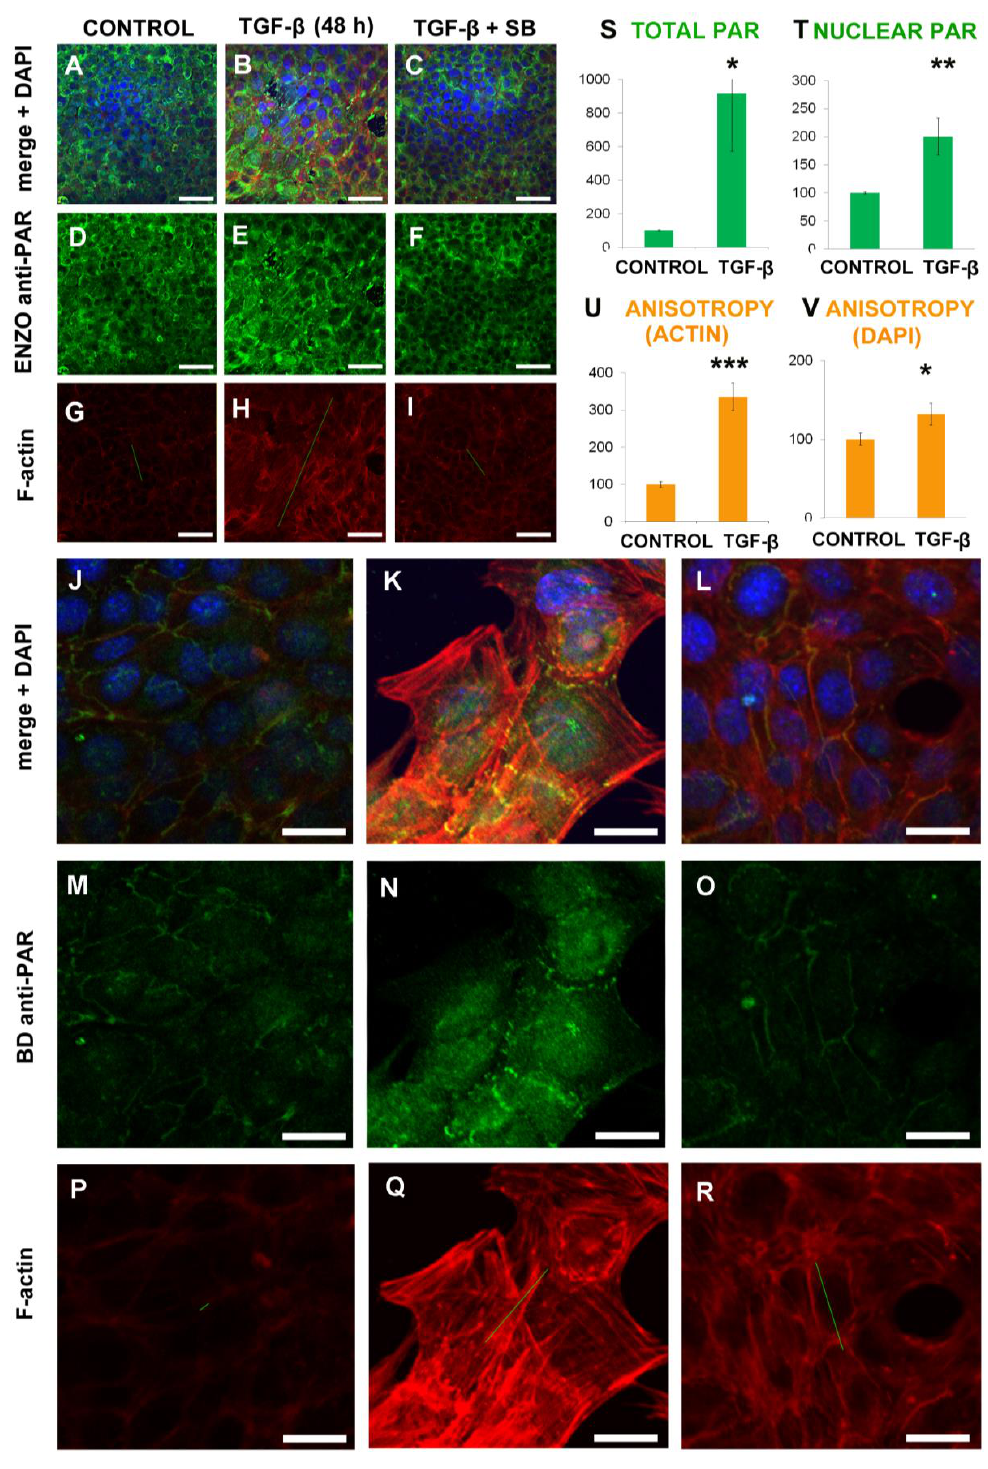
Figure 1. TGF- β induced NMuMG cells anisotropy increases together with changes in nuclear, cytoplasmic, and belt PAR. Control NMuMG cells were subjected just to 4 h of serum depletion. Other cells were also treated with TGF- β (5 ng/mL, 48 h) with or without 20 µ M SB-431542 (SB) in 0.2% DMSO. All images are confocal single planes and have undergone a Gaussian blur with ratio = 1. Top panel ( A – I ). Columns correspond to treatments: control ( A , D , G ), TGF- β ( B , E , H ) and TGF- β +SB ( C , F , I ). The first raw displays merge + DAPI (blue) nuclear counterstain ( A – C ). PAR was detected with ENZO anti-PAR antibodies (green; D – F ), F-actin, with a rhodamine-phalloidin probe (red; G – I